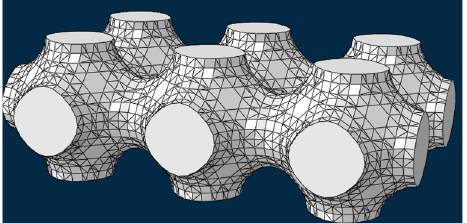
Figure 3. Schwarz primitive lattice CAD model with the help of the SP unit cell combination.